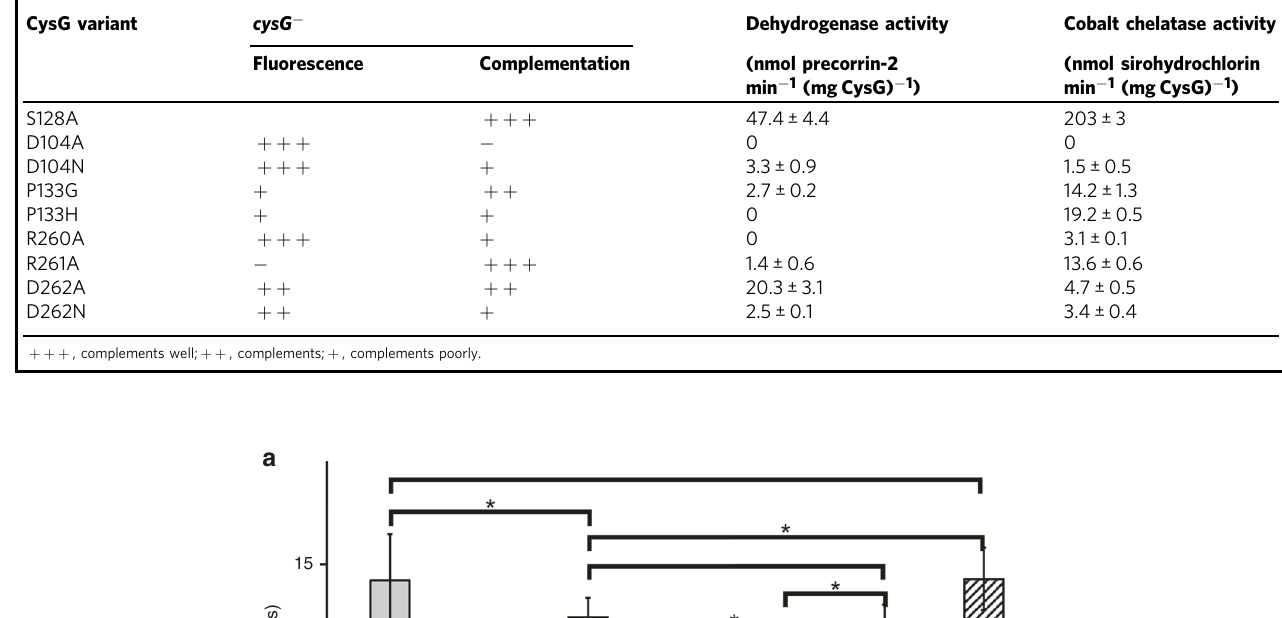
Table 1 Complementation and activity assays.